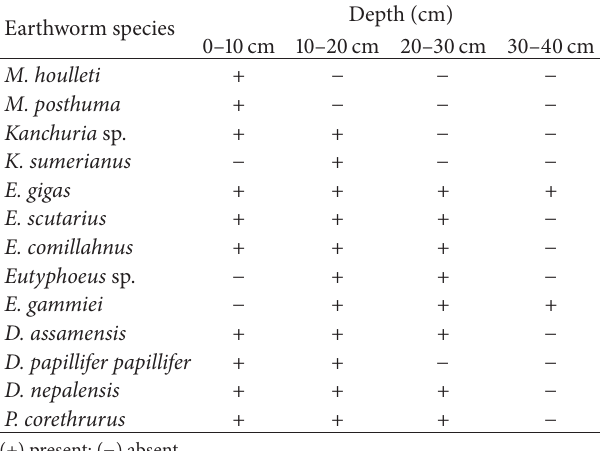
Table 3: Vertical distribution of earthworm species in different soil strata.